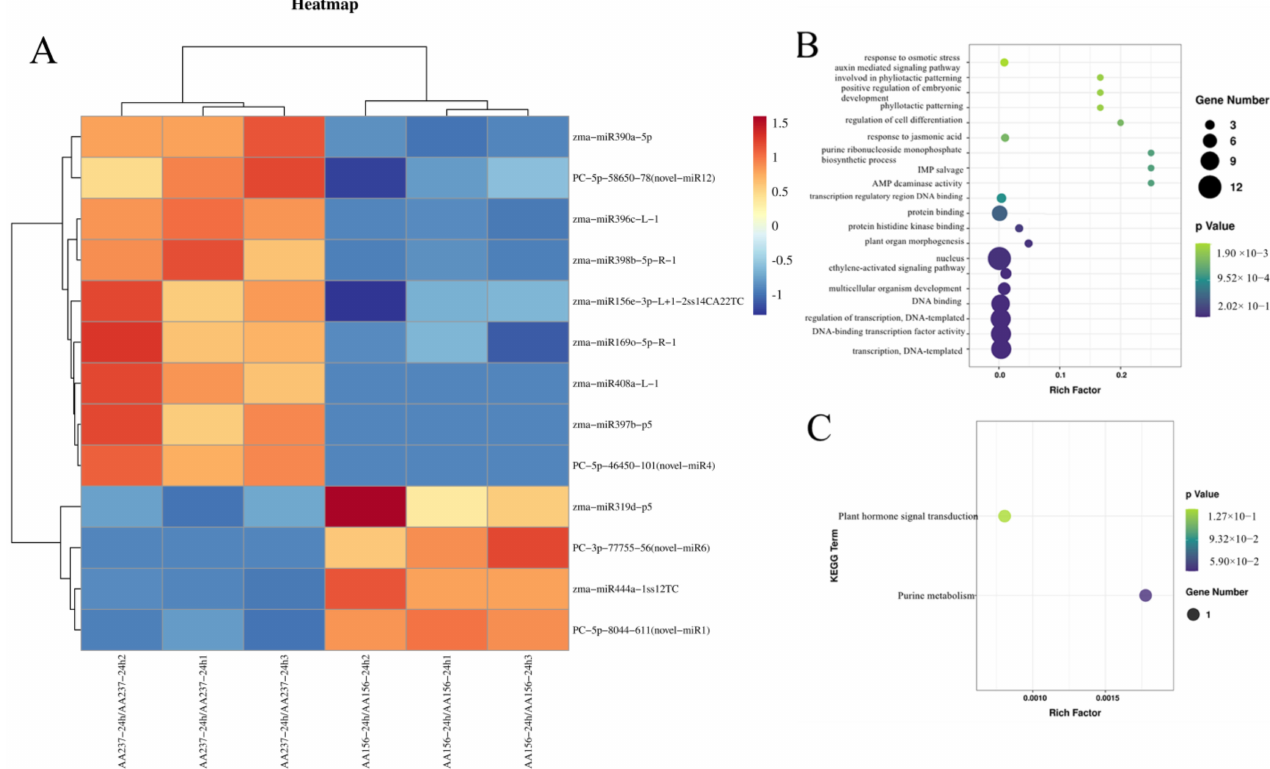
Figure 5. Analysis of the targets of identified miRNAs in maize seed storability. ( A ) Hierarchical clustering of DEGs expression. ( B ) Profile of GO analysis of the targets of identified responsive miRNAs in maize seed storability. ( C ) Profile of KEGG analysis of the targets of identified responsive miRNAs in maize seed